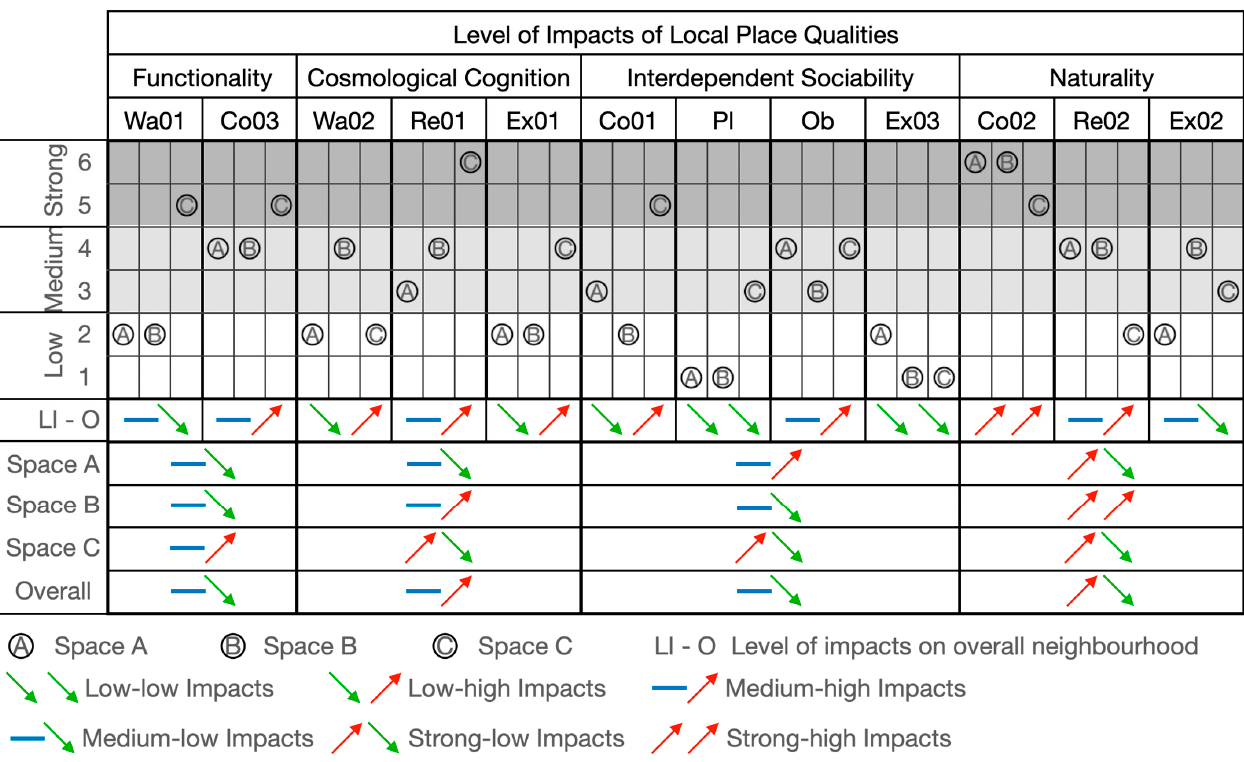
Figure 15. The level of impacts of local place qualities on users’ perceptions.